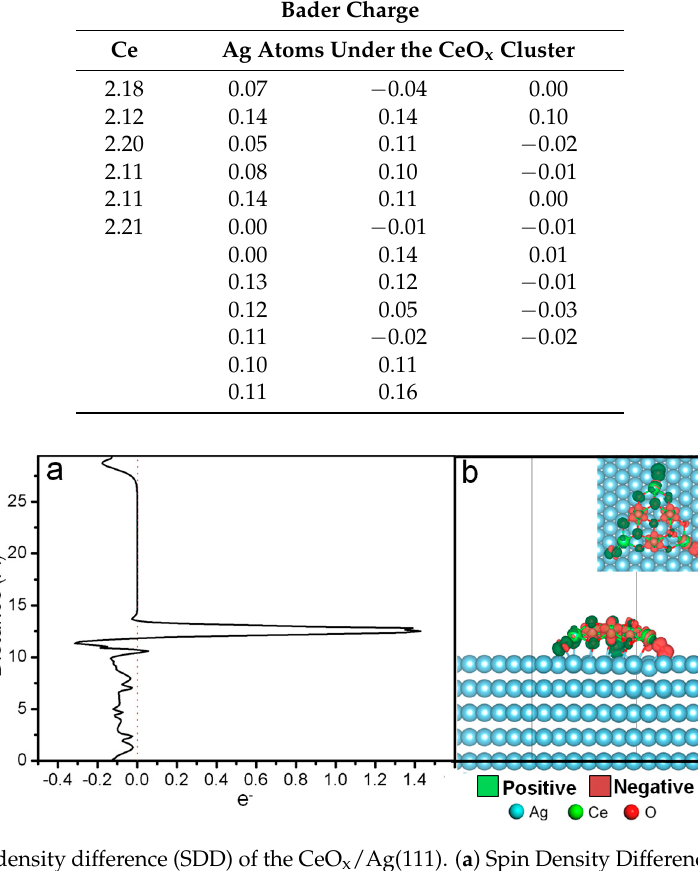
Table 1. Bader charge of the Ce and Ag atoms under the CeO x cluster of CeO x /Ag(111).